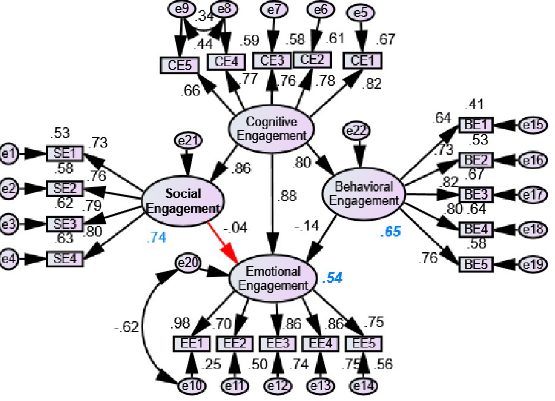
Fig 7. Effect of behavioral, cognitive and social engagement on emotional engagement (Model 4: Red arrow represents insignificant and black arrow represents significant results).